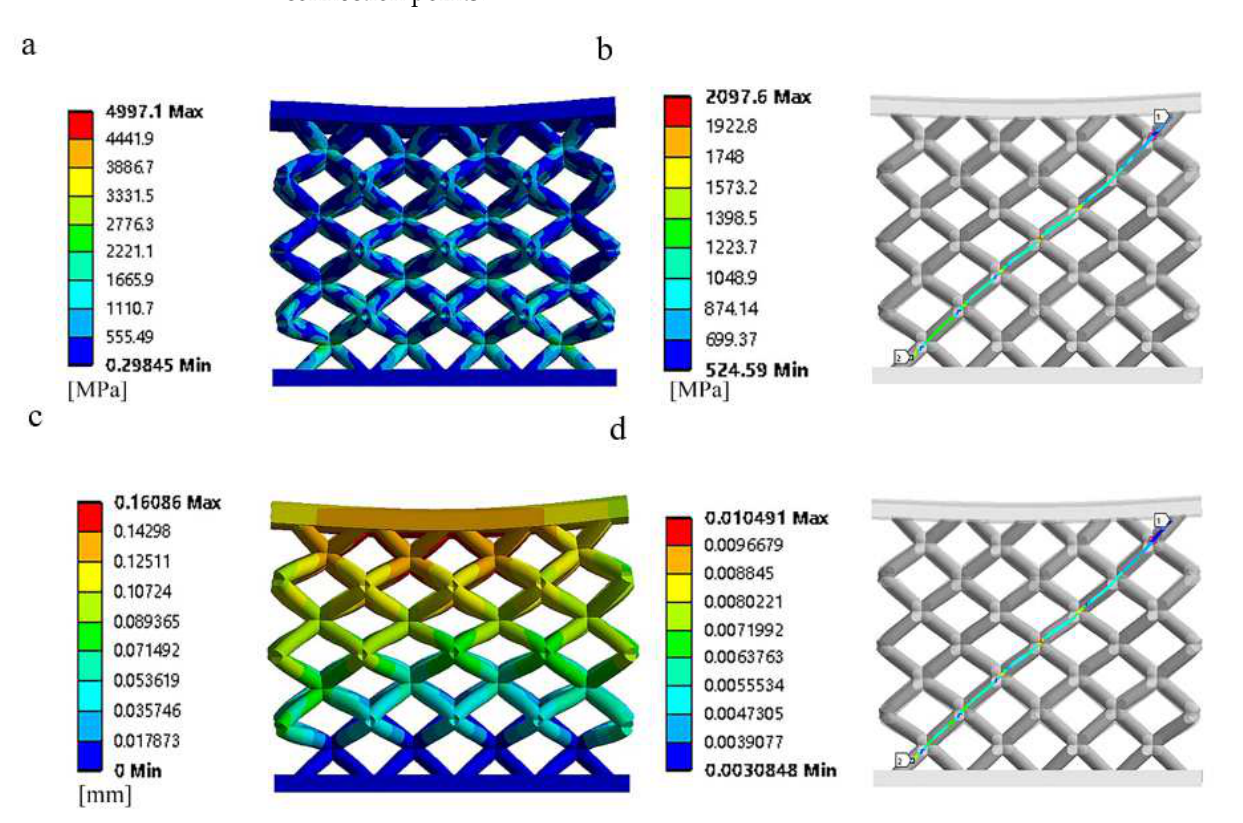
Figure 3. Nephogram of simulated compressive stress, strain, and deformation of bone scaffold: ( a ) finite element stress distribution nephogram, ( b ) diagonal stress distribution in bone scaffold, ( c ) finite element displacement distribution nephogram, and ( d ) diagonal strain distribution in bone scaffold.